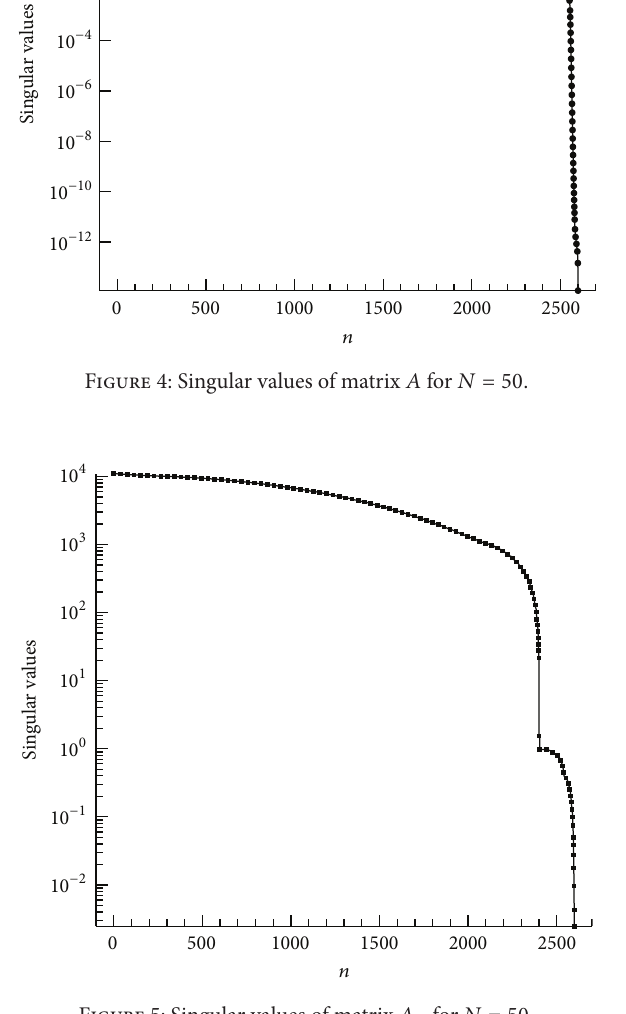
Figure 5: Singular values of matrix 𝐴 𝑇 for 𝑁 = 50 .